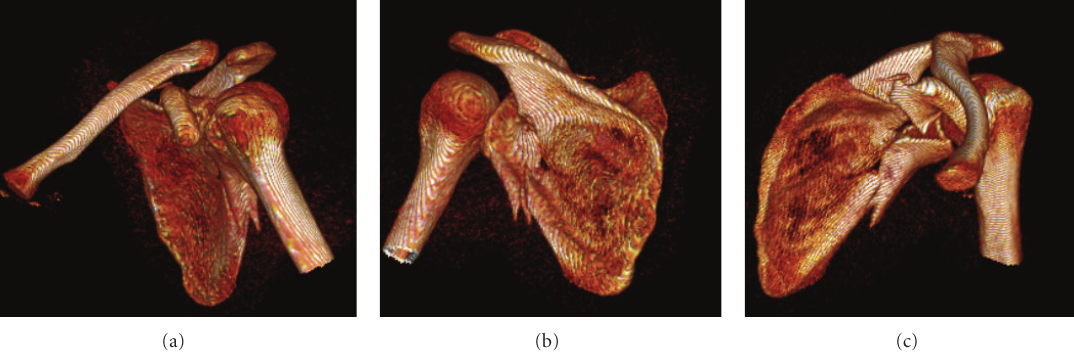
Figure 4: Three-dimensional reconstructions of the left shoulder CT